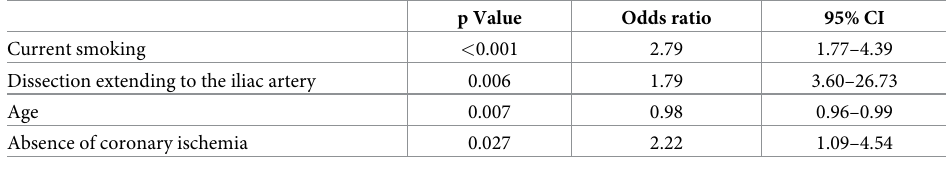
Table 3. Factors related to WBC count elevation ( > 11,000/ μ L), as determined by multivariable analysis.